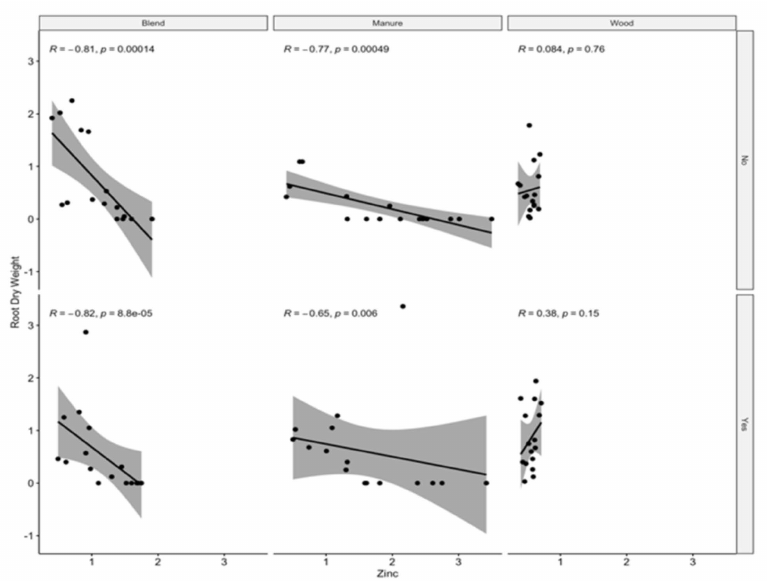
Figure 4. Root dry weight (R-DW) (g) × Zn (ppm), Spearman’s correlation for T. incarnatum by BC type and saturation (yes for